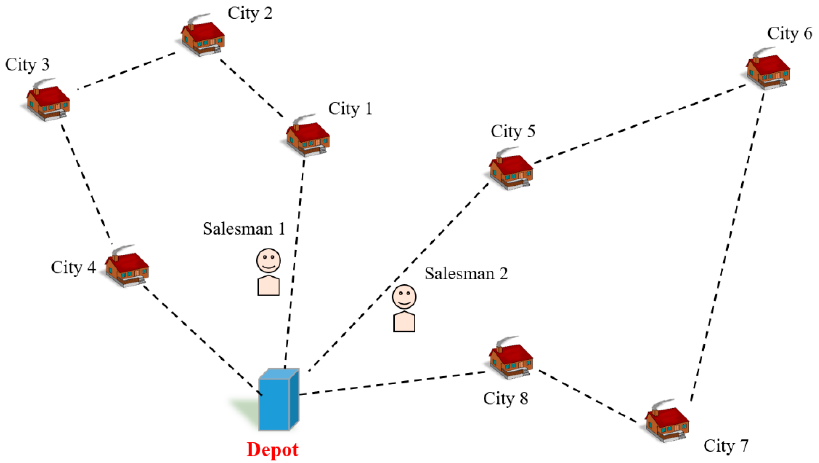
Figure 1. Schematic diagram of the multiple traveling salesman problem